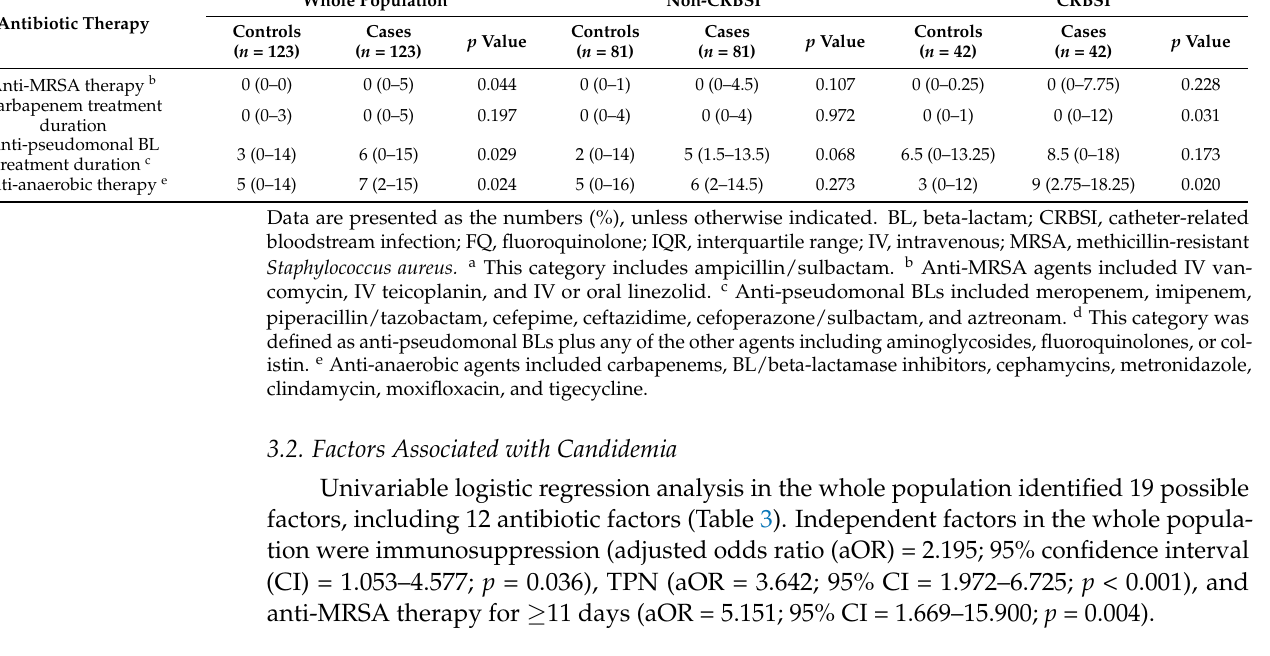
Table 3. Univariable and multivariable logistic regression analyses in the whole